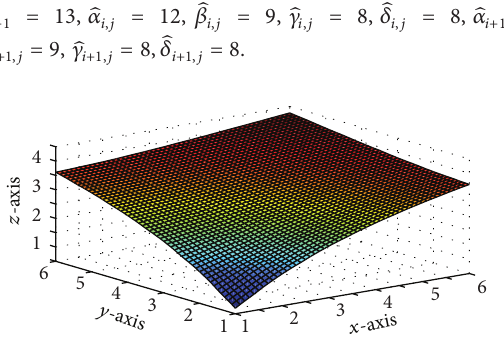
Figure 8: 𝐶 1 monotone rational trigonometric bicubic function with 𝛼 𝑖,𝑗 = 12 , 𝛿 𝑖,𝑗 = 12 , 𝛼 𝑖,𝑗+1 = 13 , 𝛿 𝑖,𝑗+1 = 14 , ̂𝛼 𝑖,𝑗 = 10 , 10 , ̂𝛼 = 15 , ̂𝛿 = 13 𝑖+1,𝑗 𝑖+1,𝑗